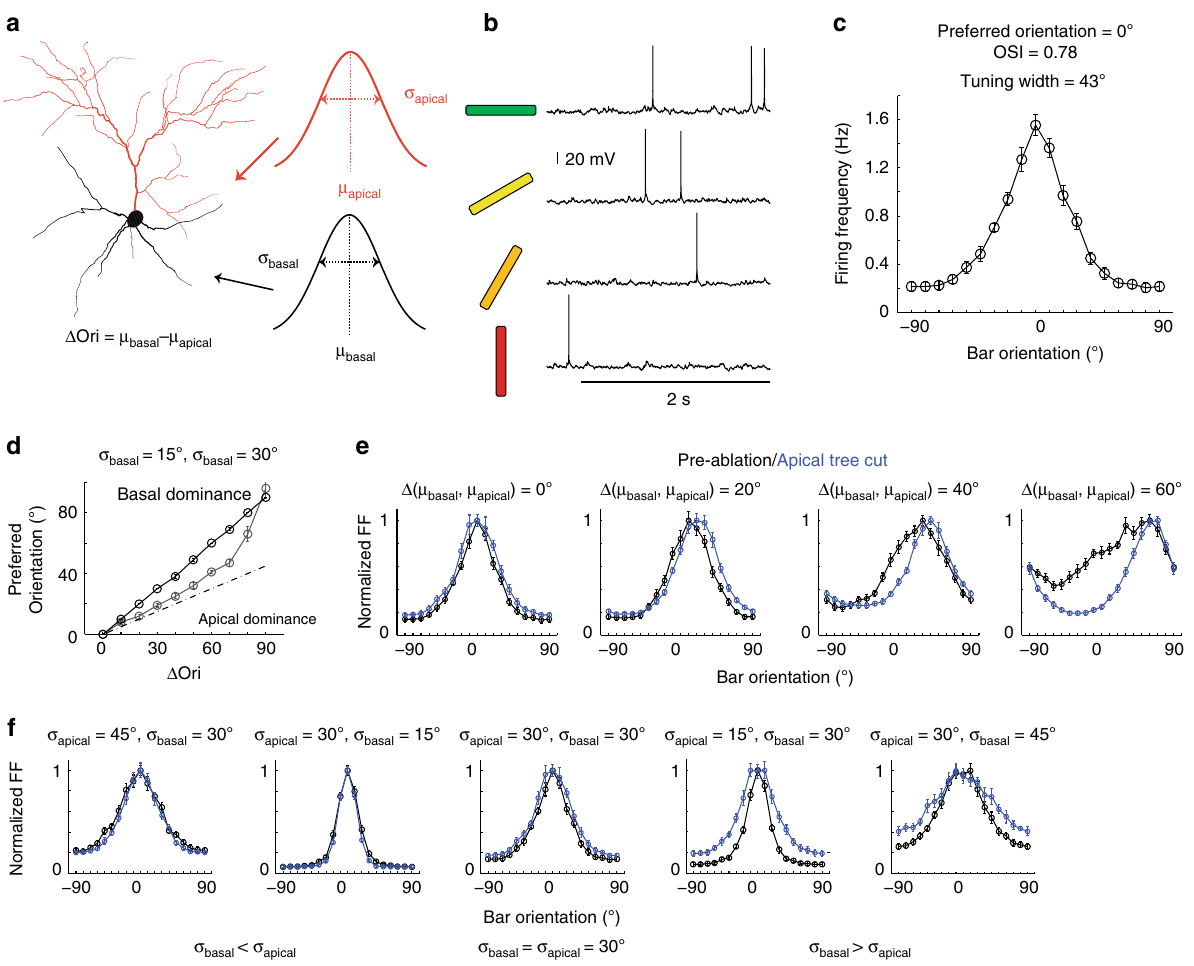
Fig. 4 Biophysically realistic modeling of apical dendrite ablation. a Reconstruction of the L2/3 pyramidal neuron used for simulation. Three main parameters, standard deviation ( σ apical ) of the distribution of pref syn in apical dendrites, standard deviation ( σ basal ) and mean ( μ basal ) of the distribution of pref syn in basal dendrites, were varied. μ apical is arbitrarily fi xed at zero. b The model neuron generates realistic subthreshold and action potential activity in response to 0°, 30°, 60°, and 90° (left) orientations. Horizontal line represents stimulus duration (2 s). c The model neuron displays realistic tuning curves (average tuning curve of 10 simulations when σ apical = σ basal = 30°, µ apical = µ basal = 0°). d The model neuron ’ s preferred orientation is biased to the basal dendrites ’ mean orientation preference for all Δ ( μ apical , μ basal ). Black line, σ basal = 15°. Gray line, σ basal = 30°. For both conditions, σ apical = 30°. Dotted line indicates equal contribution of apical and basal trees in determining somatic orientation preference. e Model neuron tuning curves pre- (black curve) and post- (blue curve) ablation of apical tree. Left two panels: At low Δ ( µ basal , µ apical ) (<30°), ablation of the apical dendrite does not affect orientation tuning curve shape; Right two panels: At higher Δ ( µ basal , µ apical ) (>30°), apical dendrite ablation leads to a shift in orientation preference and narrowing of tuning width. σ apical = σ basal = 30°. ( f ) Left two panels and the center: At σ apical > σ basal or σ apical = σ basal = 30°, ablation of the apical dendrite does not affect the tuning width; Right two panels: At σ apical < σ basal , apical dendrite ablation broadens the tuning curve. Δ ( µ basal , µ apical ) = 0°. Error bars in ( c ), ( e ), and ( f ) are standard error of the mean across